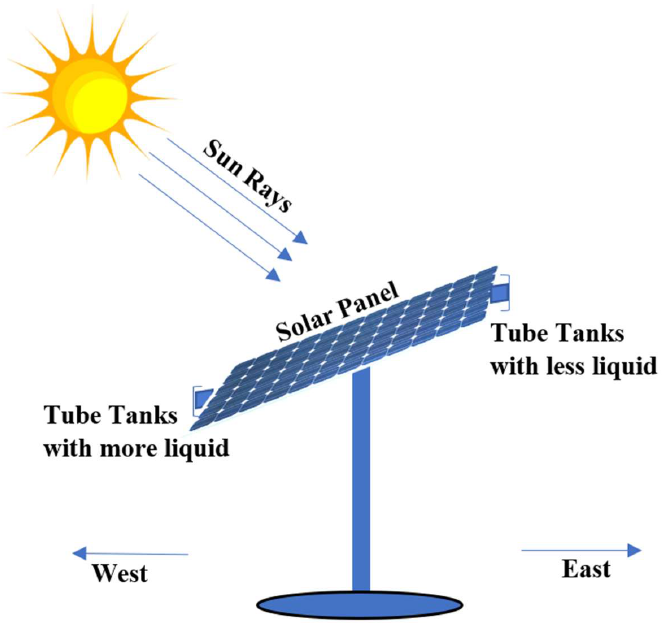
Figure 7. Passive Tracking